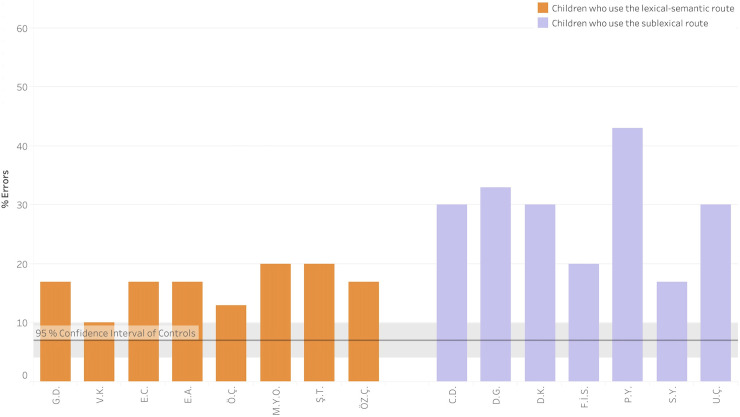
Written word comprehension task with vowel distractors–percentage errors of the participants with vowel dyslexia in comparison to controls mean and 95% CI around it.